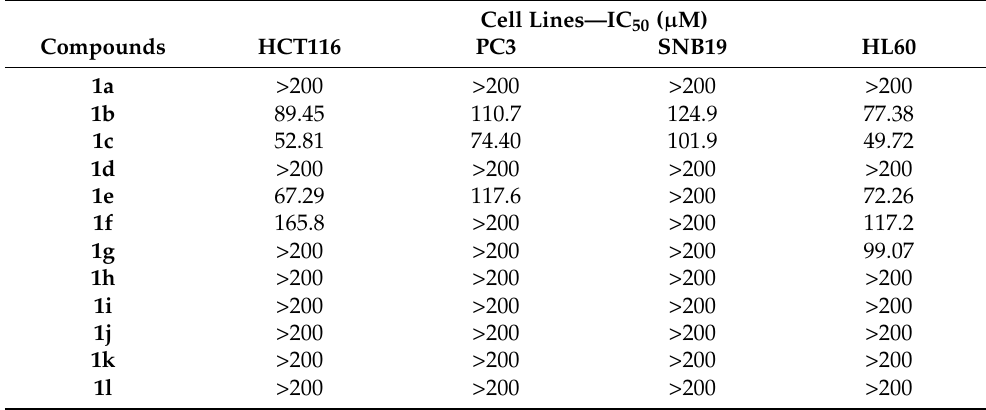
Table 3. Anti-proliferative activities of selected compounds against HCT116, PC3, HL60, and SNB19 cell lines.